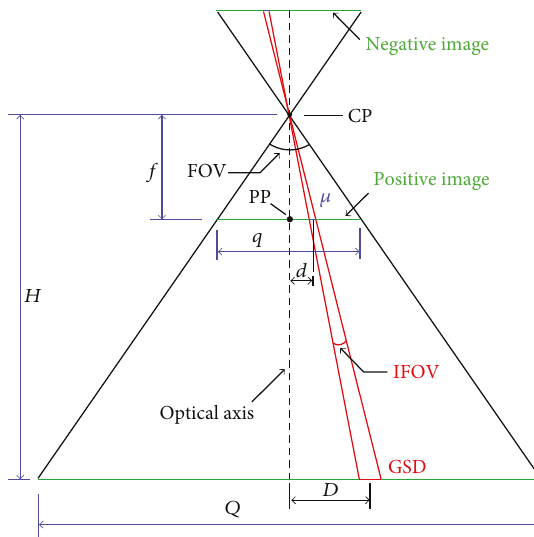
Figure 17: Geometric parameters of the pinhole camera model. f : focal length; PP: main point of collimation, intercept of the optical axis with the plane of the image; CP: perspective center, point where the light beams leave the ground and reach the image; μ : sensor pixel size; q : size of the sensor frame; Q : frame size of the projected image on the ground; GSD (ground sample distance): pixel size projected on the ground; D : size of the object on the ground; d : dimension in the image of the object with real dimension D ; H : projected distance from the CP to the ground, corresponding to the fl ight height; FOV ( fi eld of view): the total aperture angle representing the fi eld of view covered by the sensor; IFOV (instantaneous fi eld of view): the aperture angle representing the fi eld of view of a